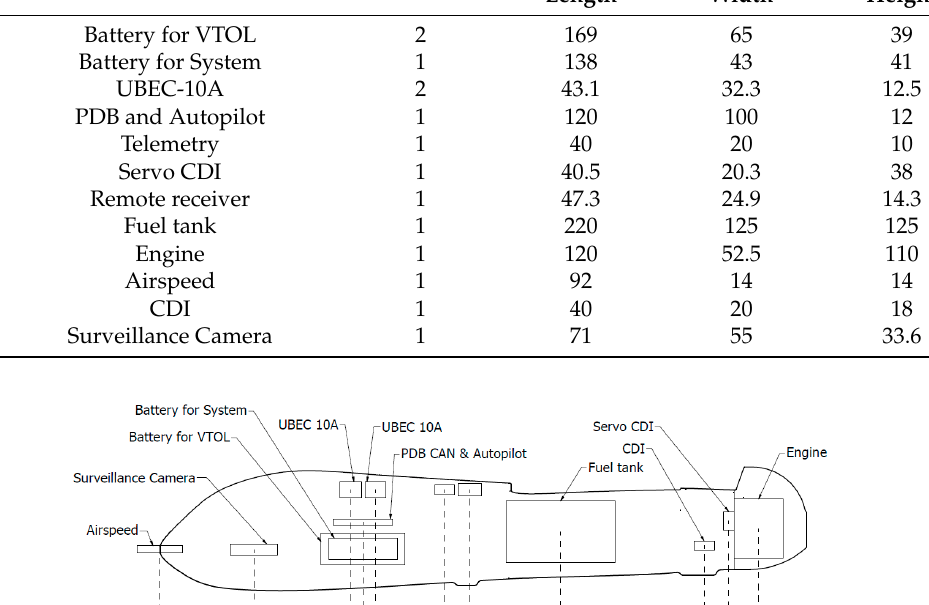
Figure 5. Payload position on the fuselage.